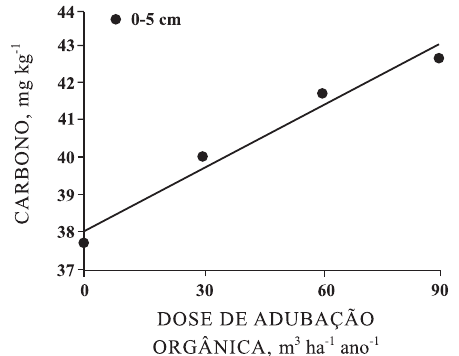
Figura 3. Teores de C-orgânico no solo submetido à adubação com diferentes doses de esterco líquido de gado leiteiro, durante seis